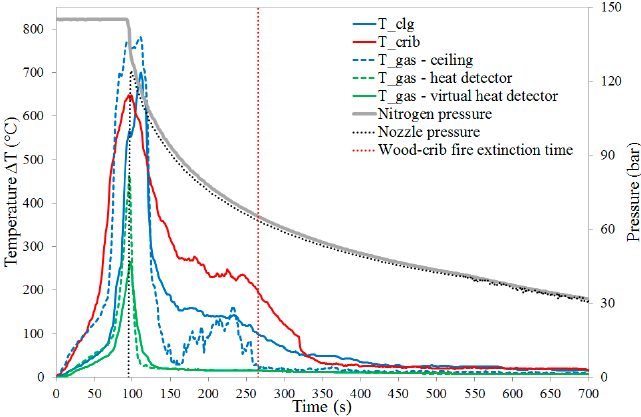
Figure 8. Temperature and pressure trends for Test no. 1.